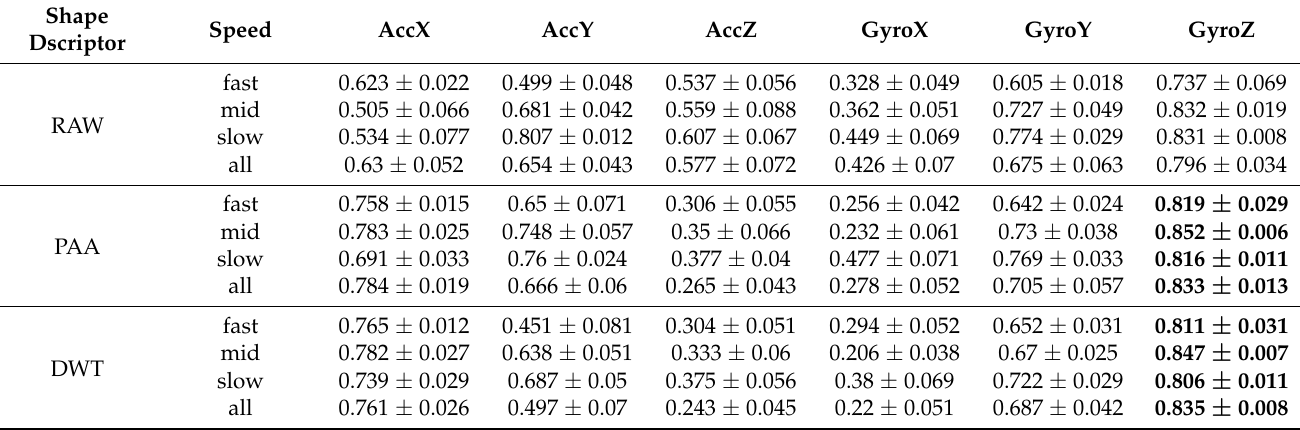
Table 3. Stride segmentation results for magnitude-aware-descriptors in F-measure values. Best results for each speed group are highlighted in bold numbers.